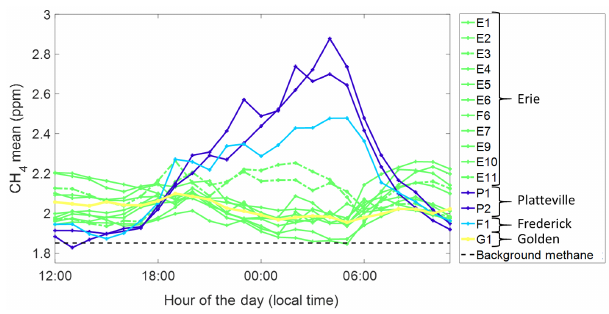
Figure 18. Mean methane value for each hour of the day, for each U-Pod, grouped and color-coded by